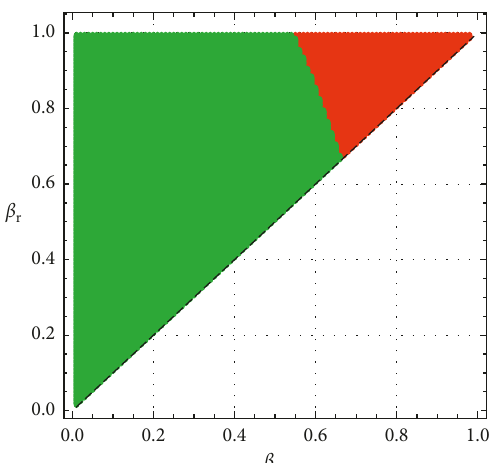
Figure 10: Comparison of steady-state profits with β � 8. θ 0